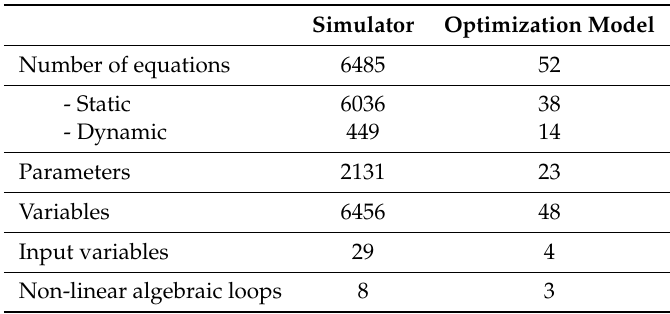
Table 1. Comparison between the model used for simulation and the model obtained for